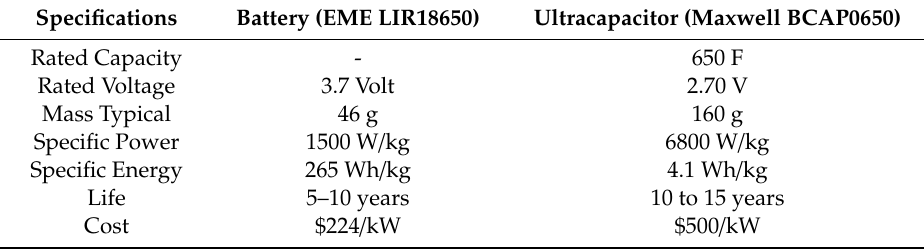
Table 2. Specifications of the battery and ultracapacitor.